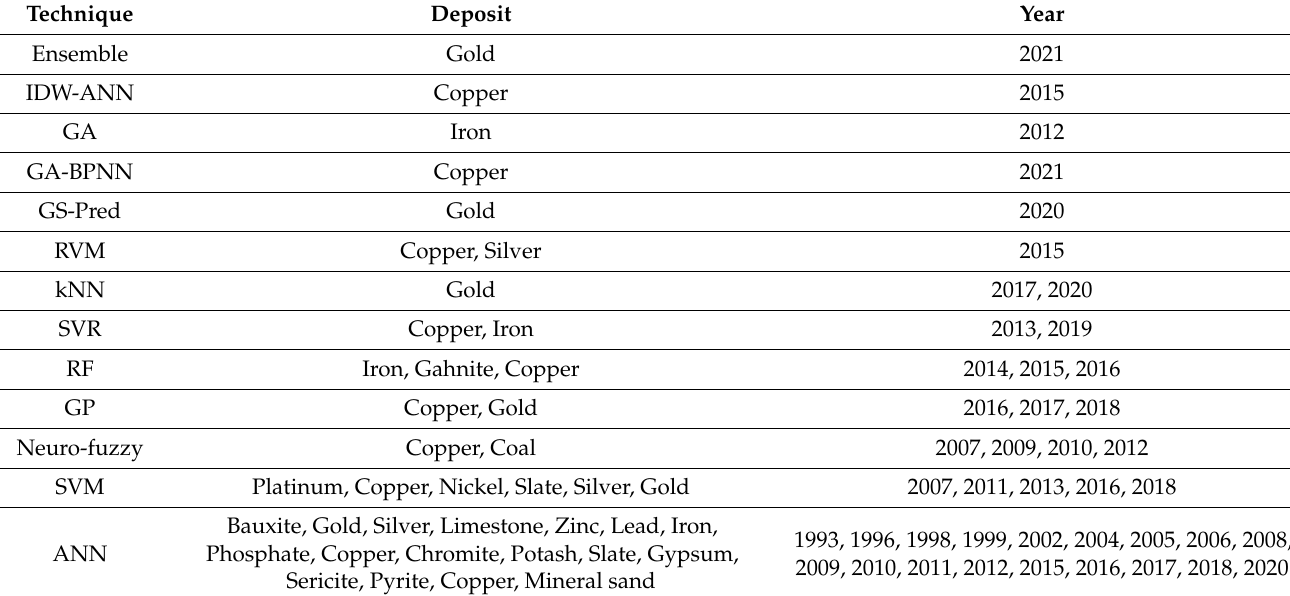
Figure 6. Distribution of mineral deposits with the machine learning application. Table 2. Summary of the various machine learning techniques applied to estimate mineral resources.